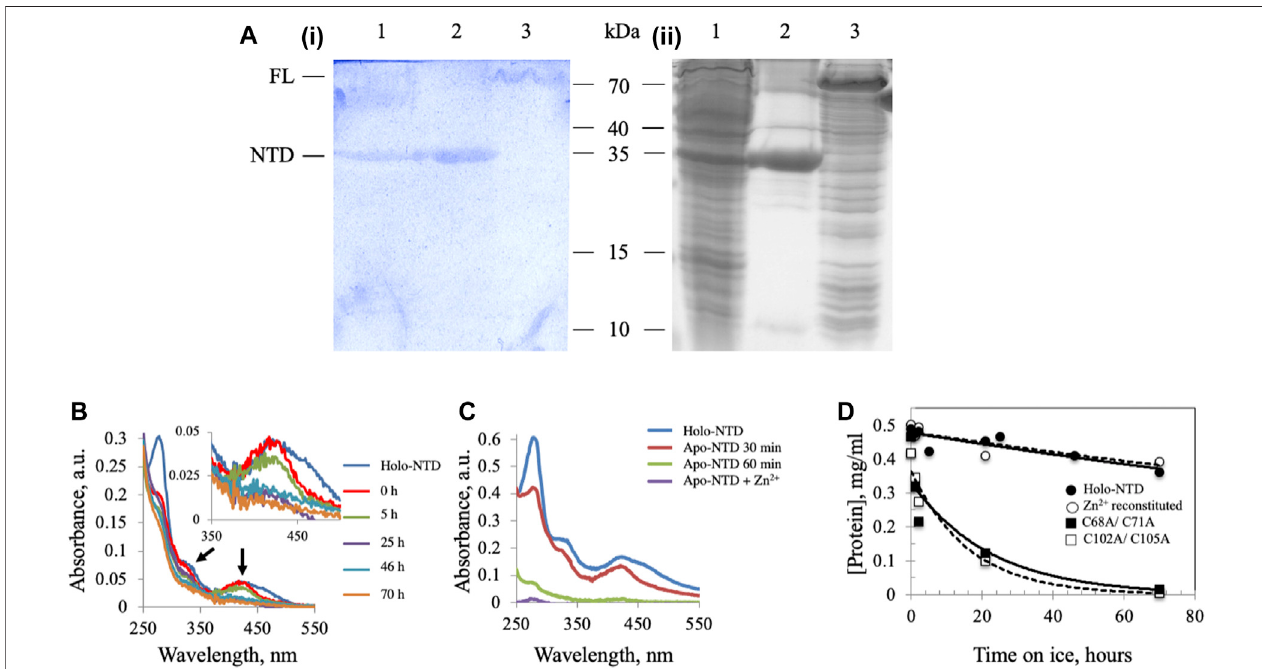
FIGURE1| Dm NTDcontainsnon-hemeironthatisrequiredforitsstability invitro . (A) Potassiumferricyanide (i) andCoomassiebrilliantbluestaining (ii) ofpartially- puri fi ed NTD overexpressed in Drosophila S2 cells (lane 1), puri fi ed NTD overexpressed in E. coli BL21 (lane 2) and overexpressed full-length Dm mtDNA helicase in an E. coli BL21 cell lysate (lane 3). (B) Representative absorbance spectra of wild-type and Zn 2+ -substituted NTD show a decrease of the characteristic ISC peaks (arrows and inset) with time of incubation on ice. (C) Extraction of the ISC from Dm NTD leads to protein loss. Representative absorbance spectra of native and ISC- depletedapo-NTD(30 minand1 hpost-extractionoftheISC)showdecreasedabsorptionatA280.SupplementationwithZn 2+ post-extractiondidnotrestoresolubility oftheapo-NTD. (D) Thestabilityofproteinswasinferredfromtheirconcentrationovertime.Theproteinconcentrationwascalculatedfromtheabsorbanceat280 nmat theindicatedtimeintervals.Wild-typeNTD(closedcircles)andZn 2+ -substitutedNTD(opencircles)remainstableoniceduringtheexperimentalperiod,whereastheISC- de fi cient variants are not (closed and open